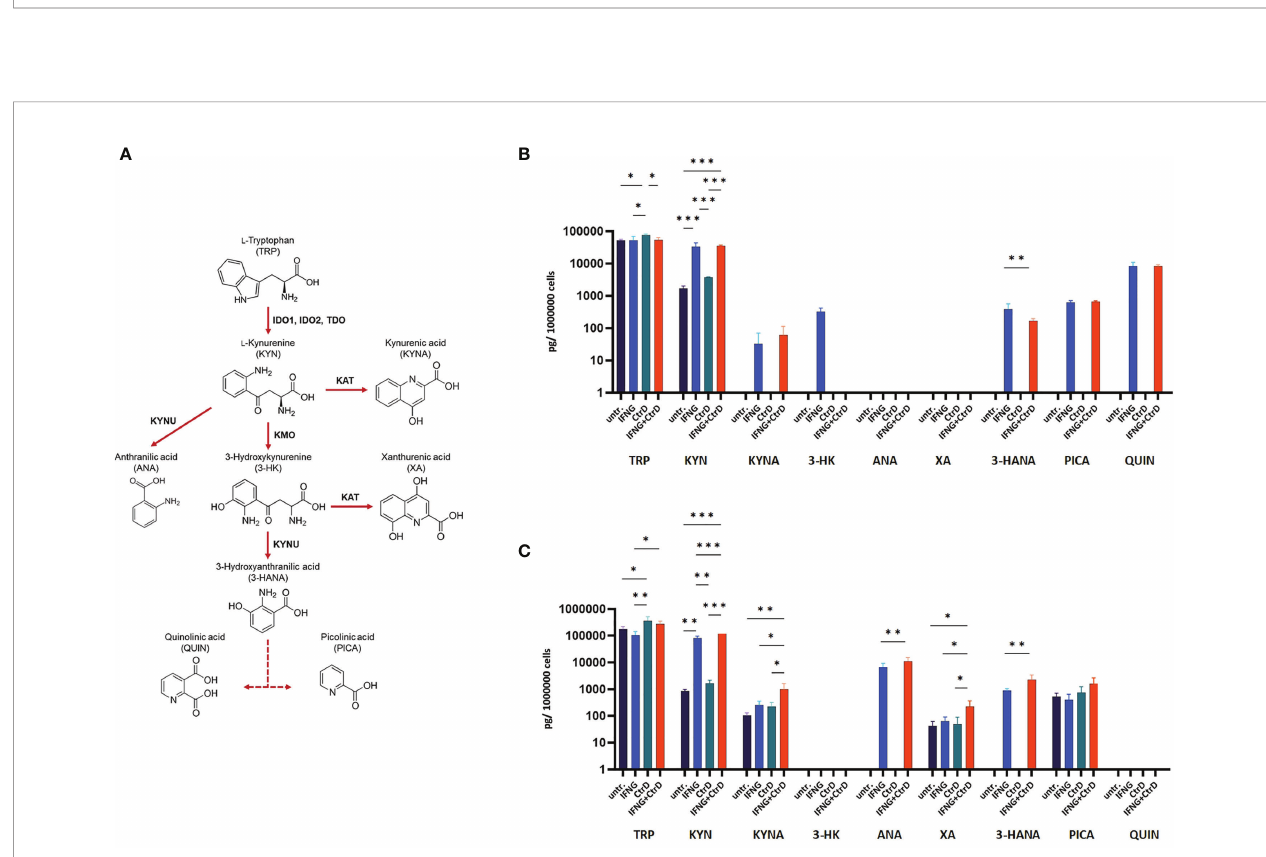
FIGURE 5 | Impact of Chlamydia trachomatis infection and interferon-gamma (IFNG) treatment on the tryptophan catabolism of HL-60 and HeLa cells. (A) Simpli fi ed pathway of tryptophan catabolism, containing the principal enzymes kynurenine aminotransferase, kynurenine-3-monooxygenase, kynureninase, indoleamine-2,3- dioxygenase, and tryptophan-2,3-dioxygenase. (B) UHPLC – MS/MS measurement of tryptophan degradation products at 24 h post-infection/treatment in C. trachomatis -infected and/or IFNG-treated HL-60 cells. (C) UHPLC – MS/MS measurement of tryptophan degradation products at 24 h post-infection/treatment in C. trachomatis -infected and/or IFNG-treated HeLa cells. TRP, L-tryptophan; KYN, L-kynurenine; KYNA, kynurenic acid; 3-HK, 3-hydroxykynurenine; ANA, anthranilic acid; XA, xanthurenic acid; 3-HANA, 3-hydroxyanthranilic acid; PICA, picolinic acid; QUIN, quinolinic acid. Data are mean±SD ( n =4). One-way ANOVA with correction for multiple testing was used to compare the metabolite concentrations between uninfected/untreated and infected and/or IFNG-treated cells. * P < 0.033; ** P < 0.002; *** P <